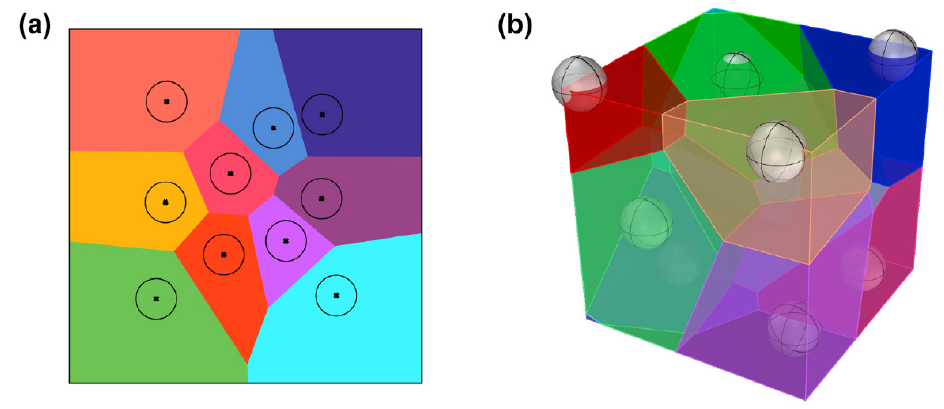
Figure 1. Schematic illustration of Voronoi-tessellation: ( a ) 2D diagram; ( b ) 3D diagram [41]. In this study, nTopology (nTopology, New York, NY, USA) software [56] was utilized to design the samples with geometrical dimensions shown in Figure 2. The sample was based on a cylinder (grey) with 10 mm in diameter and 2 mm in height. The design space for the Voronoi structure was a cylinder (green) with 9.7 mm in diameter and 1 mm in height. The diameter of the design space has been reduced by the designed strun diameter so that the Voronoi structure does not exceed the base of the sample. The total height of the sample was 3 mm. The seed points were randomly generated with a predeterminate average distance of 1 mm. The design strun diameter was 0.3 mm.